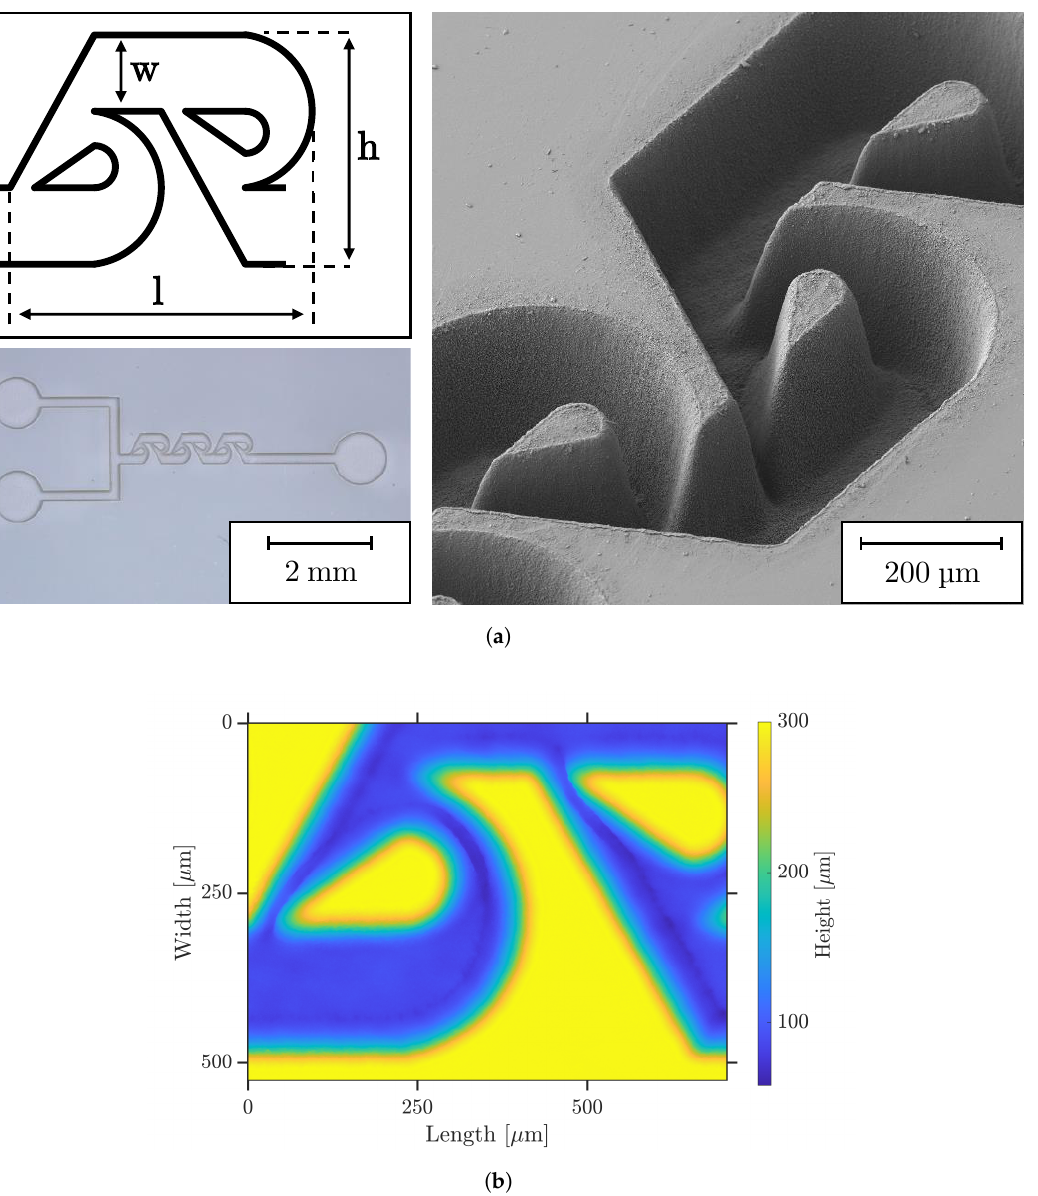
Figure 11. Exemplification of an UV USP laser ablated microfluidic Tesla mixer leaning on [48]. ( a ) Top left: design of one Tesla sturcture geometry with l = 790µm, w = 200µm and h = 600µm. Bottom left: optical micrograph of one of eight mixers. Right: 45°-tilted SEM image. ( b ) LSM